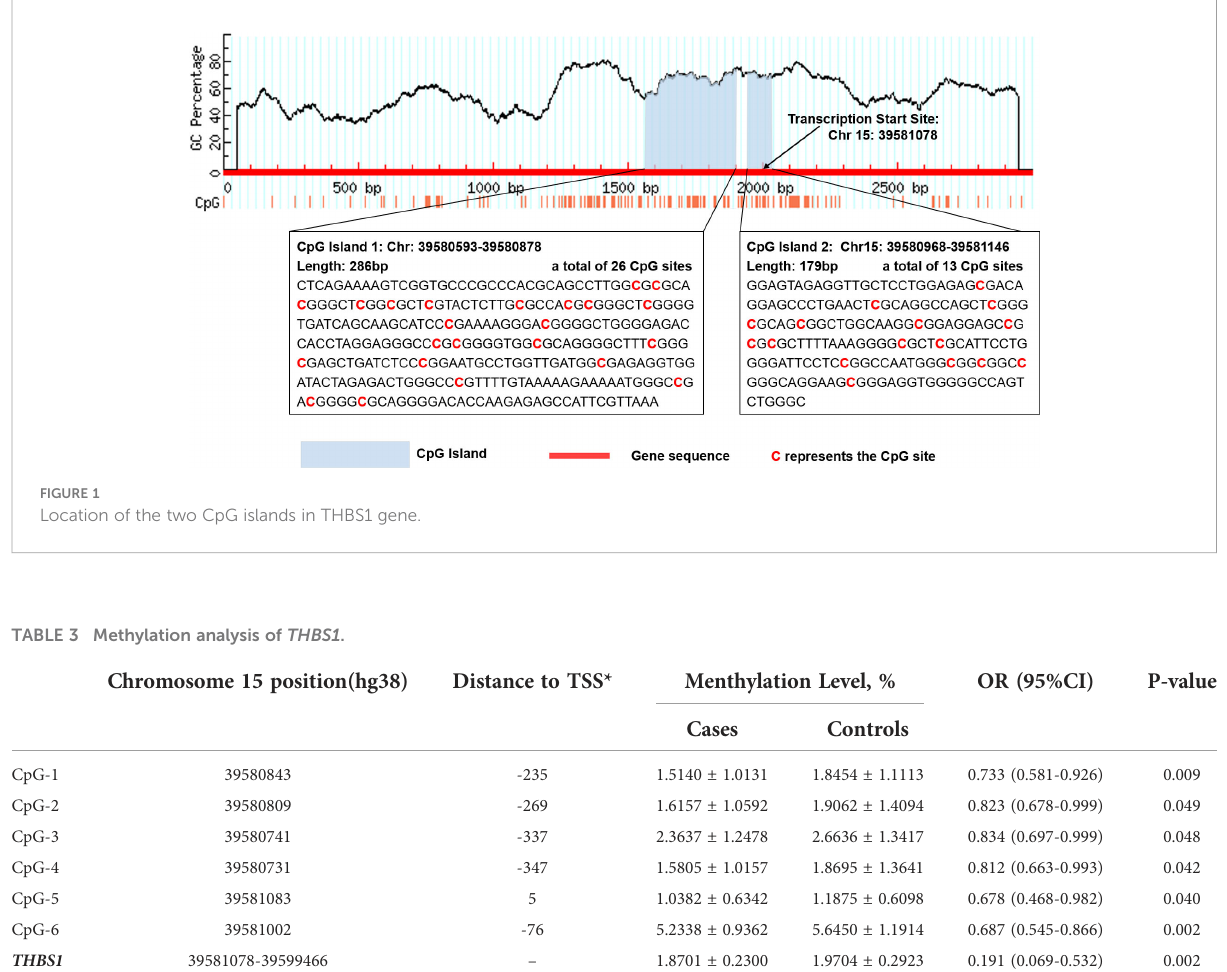
( Table 4 ) . Analysis of indirect effects showed that the variant allele of rs34973764 predicted hypomethylation levels at CpG-4 (a=-0.272, p value=0.009), and the incidence of DR increased with hypomethylation level at CpG-4 (b=-0.197, p value=0.0596) ( Figure 5 ) . Although the total and direct effect of rs34973764 on DR were not signi fi cant (total effect: c=-0.006, p value=0.973; direct effect: c ’ =-.0575, p value=0.7464), the indirect effect